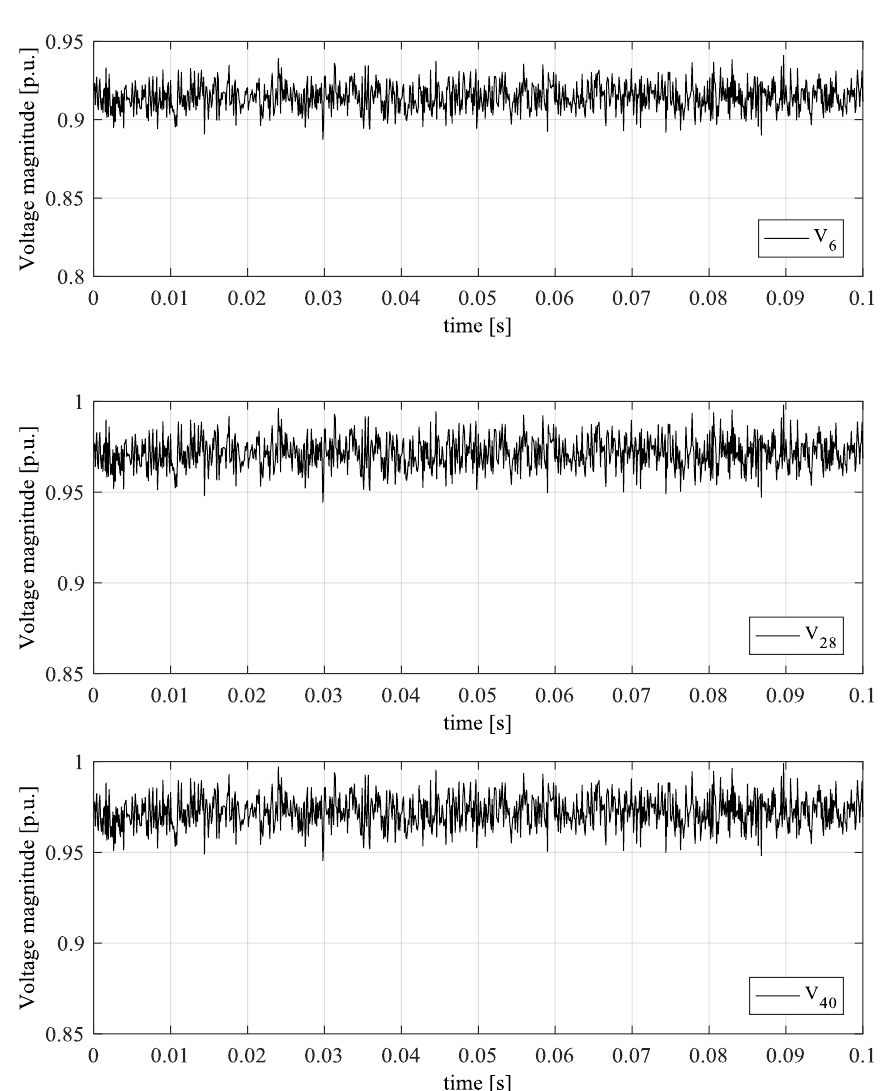
Figure 7. The simulated voltage magnitudes on the three control buses: 6, 28, and 40.